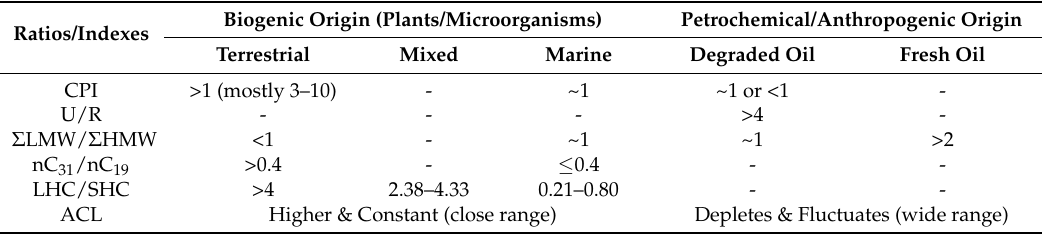
Table 9. Molecular ratios and indexes for source identification of hydrocarbons in the coastal water and